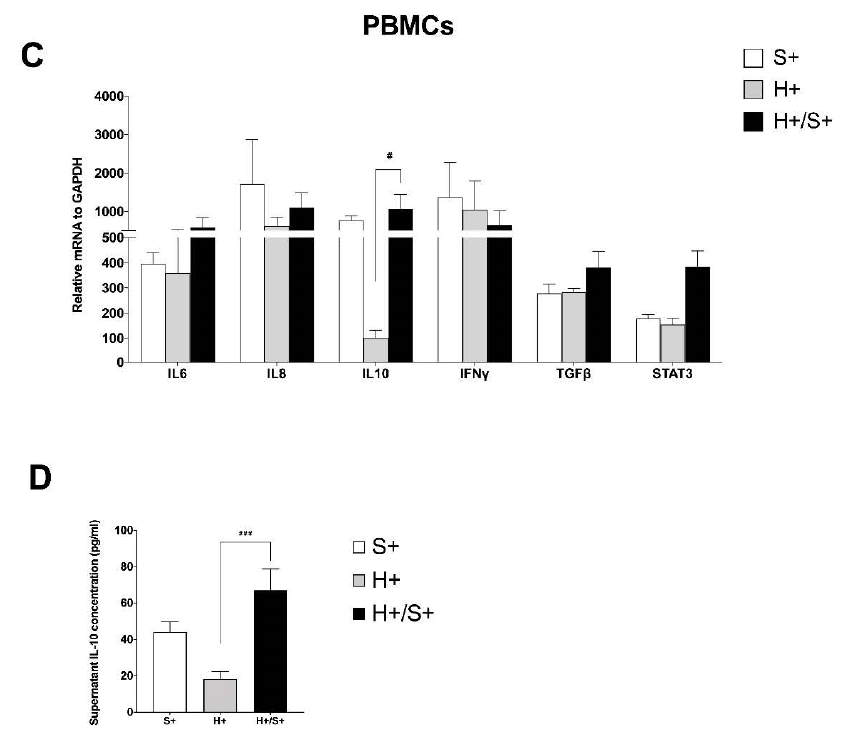
Figure 3. IL-10 expression and production are increased in in vitro coinfection. ( A ) Viral load expressed as copy number of N1 and N2 genes in SARS-CoV-2 infected only Calu-3 cells (white bar) and SARS-CoV-2-infected Calu-3 cells exposed to HIV-infected PBMCs (black bar). ( B ) mRNA expression of IL6, IL8, IL10, IFNG, TGF β 1 , and STAT3 , assessed by RT-Real-Time PCR, on Calu-3 from different conditions: Calu-3 infected only with SARS-CoV-2 (S+, white bar), not-infected Calu-3 cells exposed to HIV-infected PBMCs (H+, grey bar), and Calu-3 SARS-CoV-2-infected exposed to HIV-infected PBMCs (H+/S+, black bar); ( C ) mRNA expression of IL6, IL8, IL10, IFNG, TGF β 1, and STAT3 , assessed by RT-Real-Time PCR, on PBMCs from different conditions: not-infected PBMCs exposed to SARS-CoV-2-infected Calu-3 (S+, white bar), HIV-infected only PBMCs (H+, grey bar), and HIV-infected PBMCs exposed to SARS-CoV-2-infected Calu-3 cells (H+/S+, black bar). Results are shown as the media of the relative expression units to the glyceraldehyde-3-phosphate dehydrogenase (GAPDH) as reference gene calculated by the 2 −ΔΔ Ct equation. ( D ) Supernatant IL-10 concentrations (pg/mL) from in vitro co-cultures. Results are expressed as mean ± SEM and statistically significant differences ( p < 0.05) are indicated; * p < 0.05; # p < 0.05; ### p < 0.001; #### p < 0.0001.